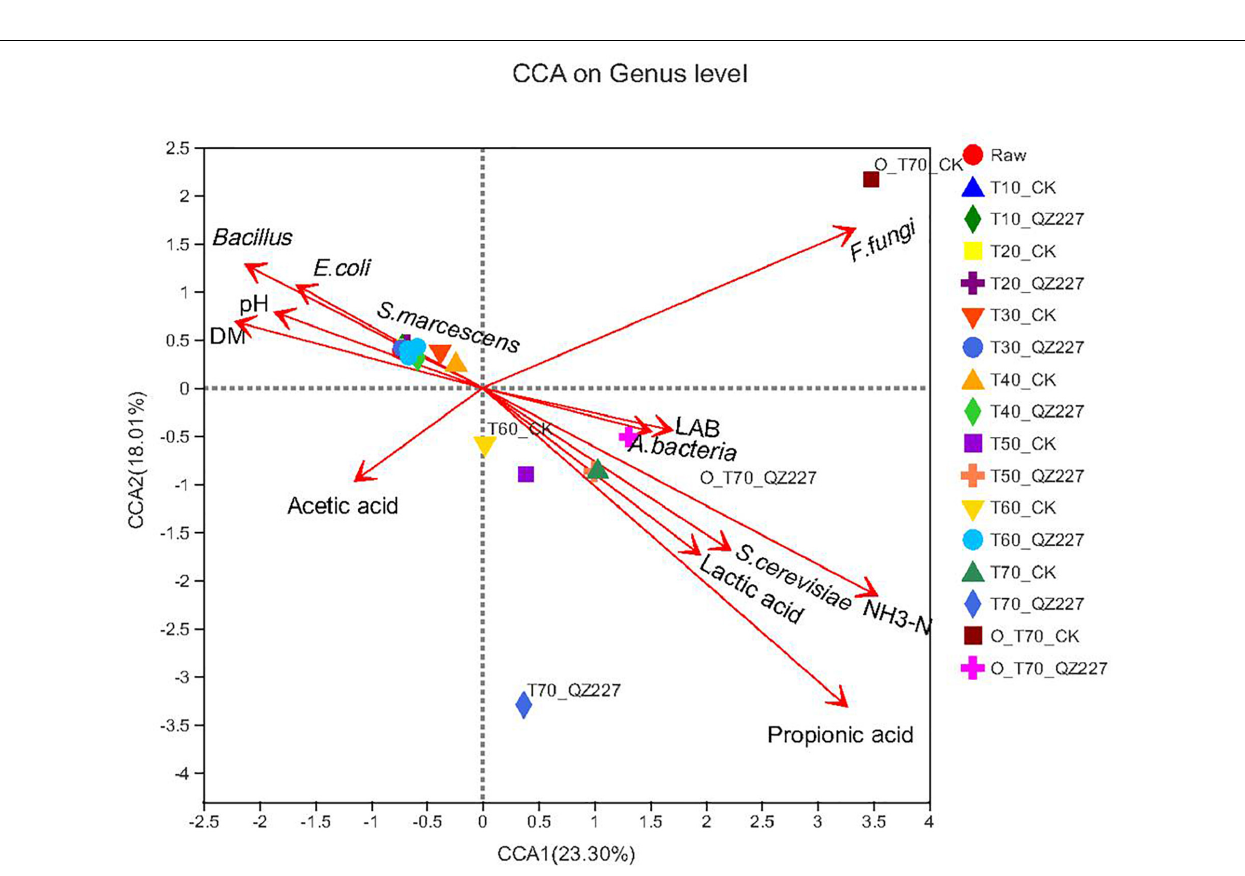
Frontiers in Microbiology |